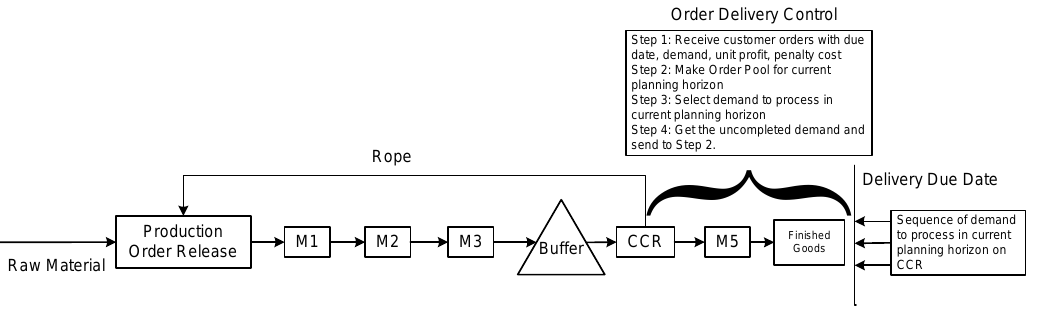
Figure 1. Order releasing and scheduling for a multi-item MTO industry in the production line.